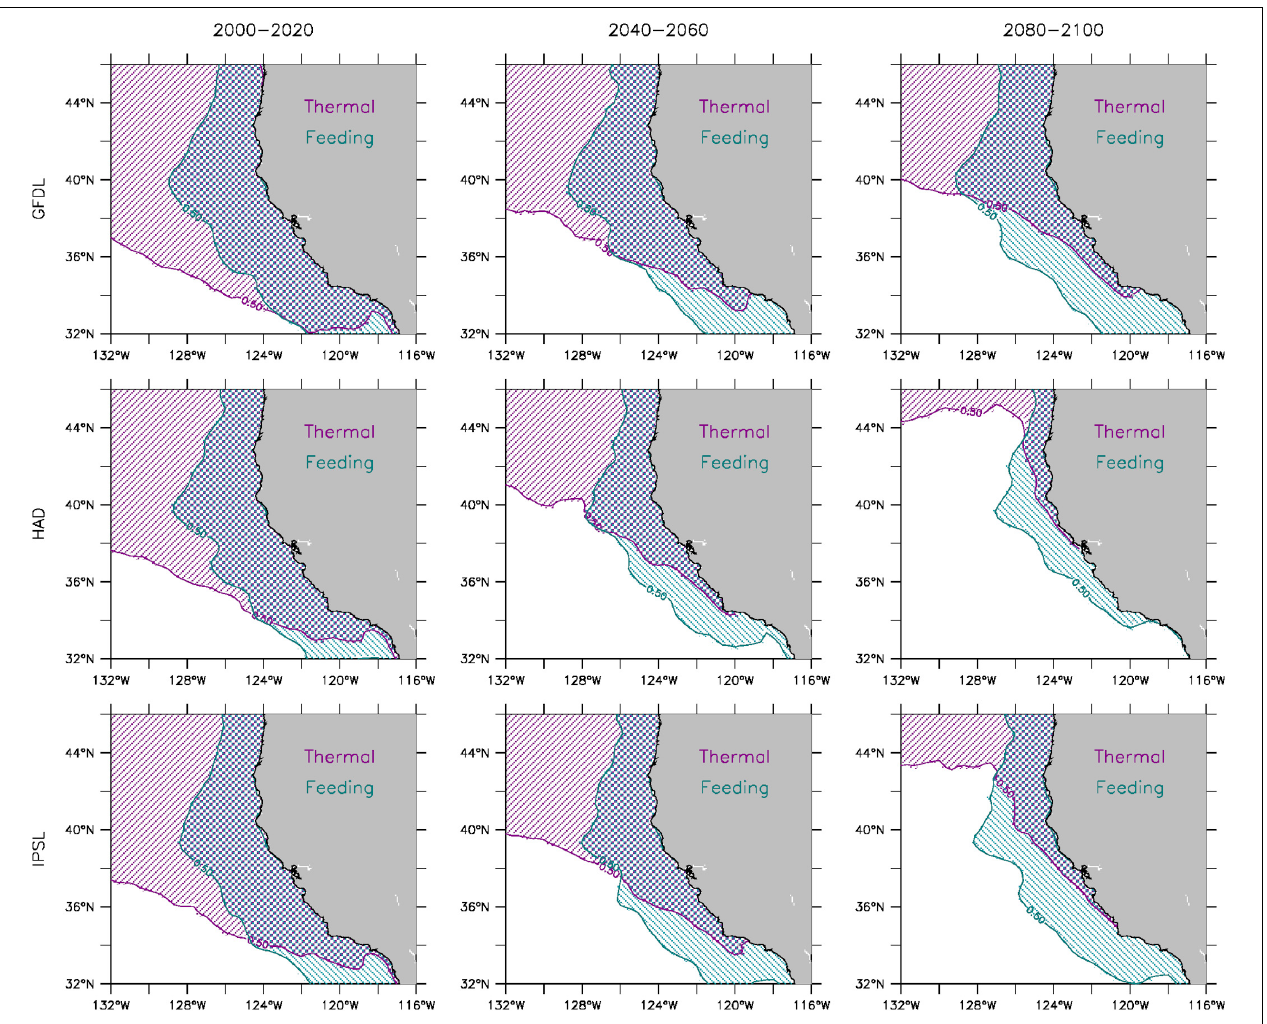
FIGURE 5 | Feeding and thermal habitat suitability for adult sardines during 2000–2020 (left) , 2040–2060 (center) , and 2080–2100 (right) from GFDL (top) , Hadley (middle) , and IPSL (bottom) solutions. Shading denotes locations where temperature (magenta) and fraction of maximum consumption (P) (cyan) are within one standard deviation of their respective optimal values (as defined in kinesis for horizontal behavior) at least 50% of the